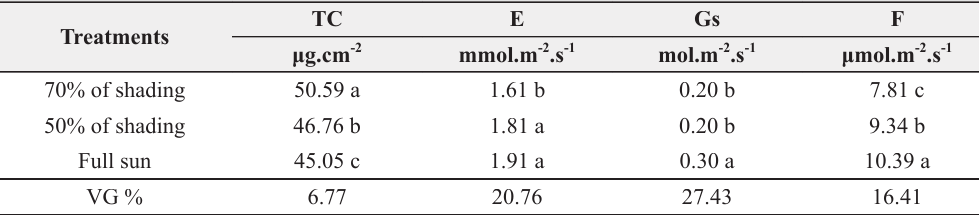
Total chlorophyll (TC), transpiration (E), stomatic conductance (Gs) and photosynthesis (F) of Myracrodruon urundeuva Allemão seedlings due to different levels of shading. UFGD, Dourados-MS, Brasil,